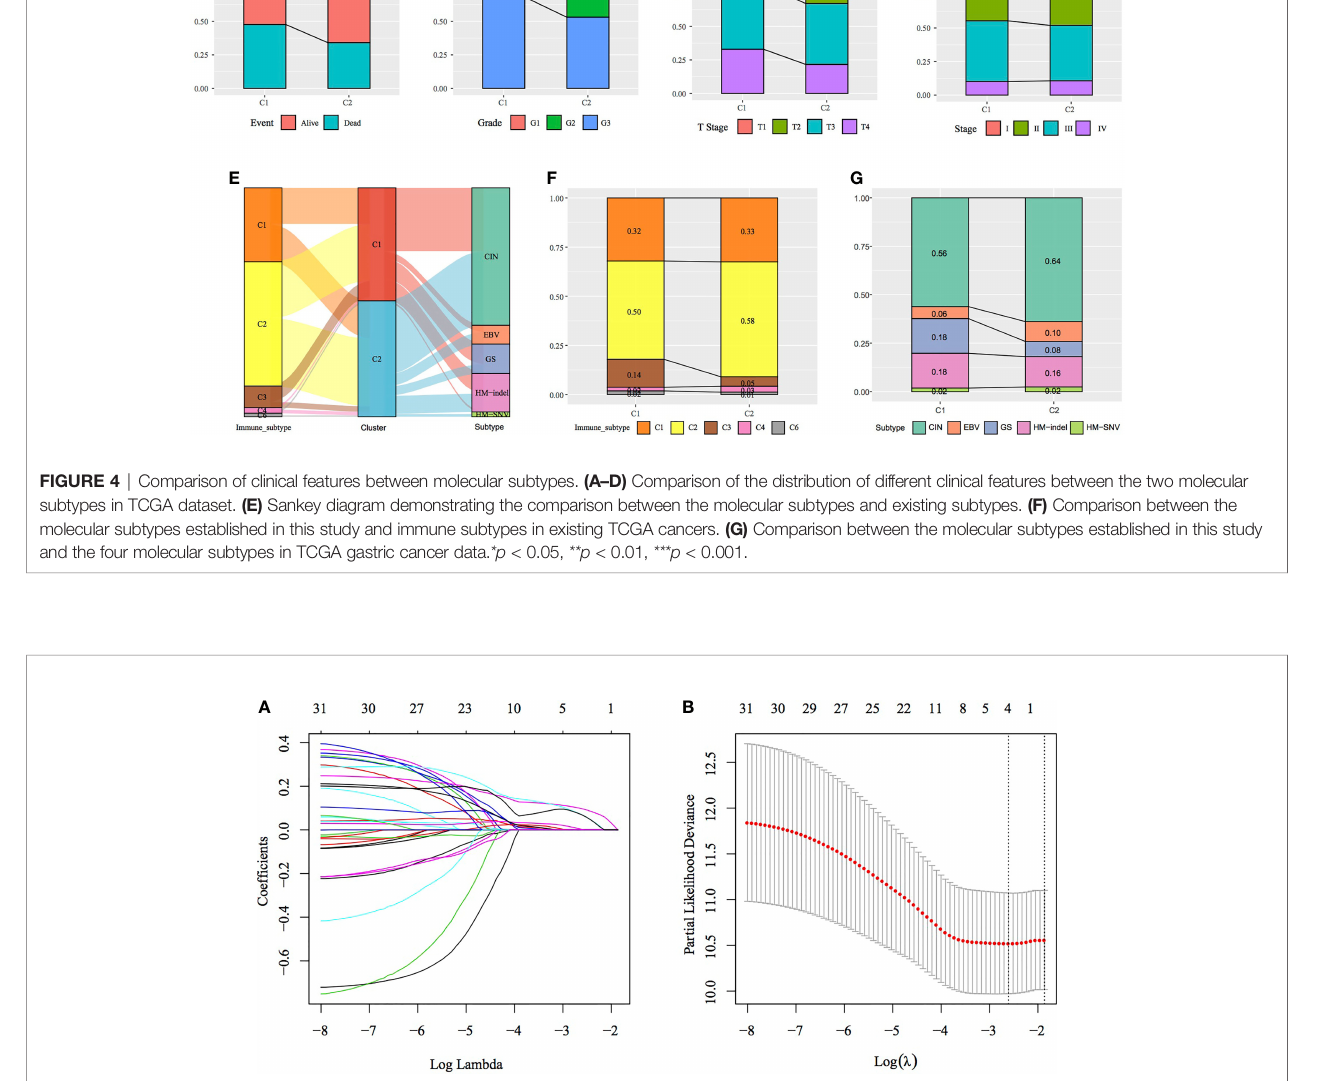
FIGURE 5 | Construction of a multigene model using lasso – Cox regression. (A) Trajectory of each independent variable, wherein the horizontal axis represents the log value of the independent variable lambda and the vertical axis represents the coef fi cient of the independent variable. (B) Con fi dence interval under each